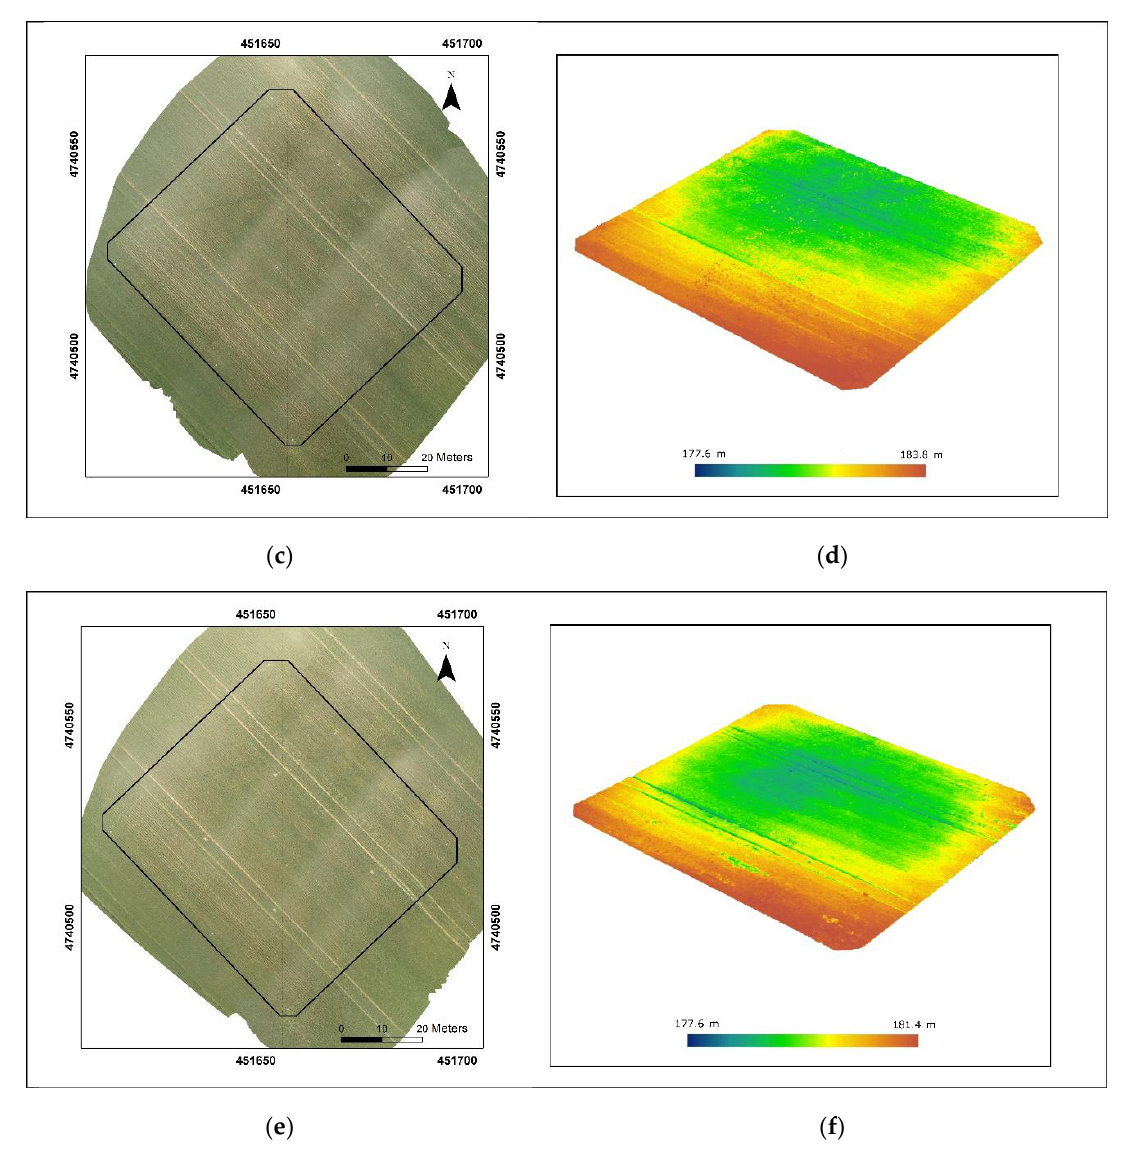
Figure 2. 2D UAV orthomosaic images for the study area during three growth stages, ( a ) 16 May, ( c ) 31 May, ( e ) 9 June; 3D Point cloud dataset for the black boundary area in perspective view, ( b ) 16 May, ( d ) 31 May, ( f ) 9 June. The color scheme bar showed the elevation (above sea level) of the point cloud dataset.